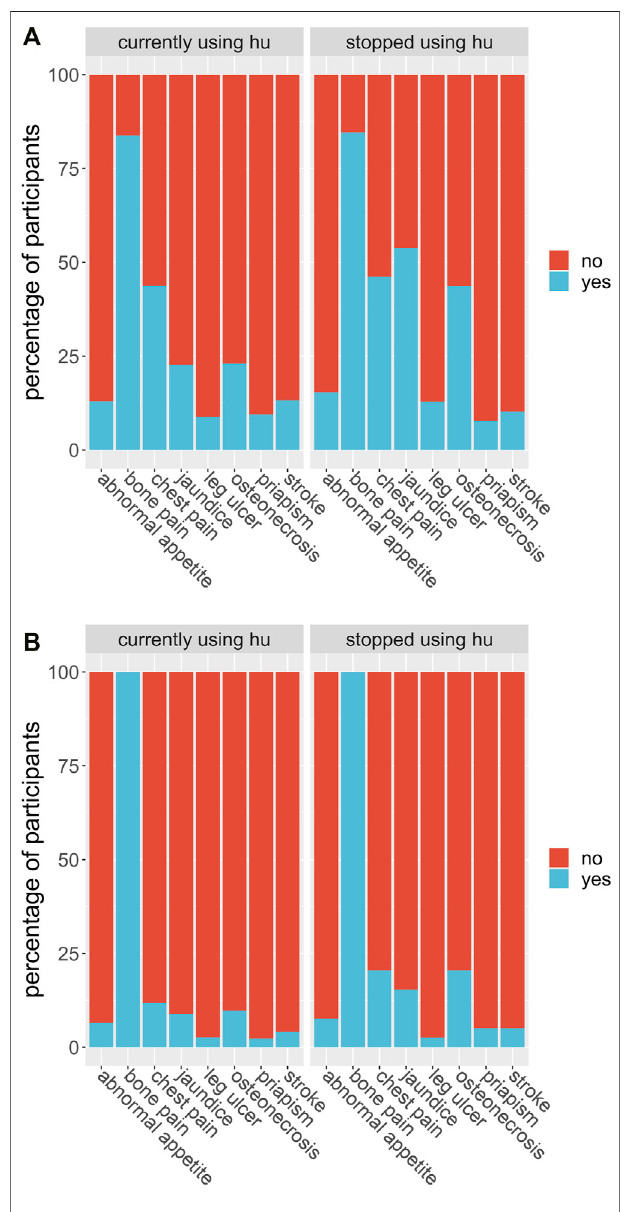
FIGURE6|(A) Participantswereaskediftheysufferedfromeachofalist of known sickle cell disease complications before they began their hydroxyurea treatment. The proportion of participants out of the entire study group who answered yes, they did suffer from that complication before treatment (blue) or no, they did not (red) are shown in the bar labelled by that complication (axis), for each complication in the list. (B) Participants were asked if they suffered from each of a list of known sickle cell disease complications after they began their hydroxyurea treatment.The proportion of participants out of the entire study group who answered yes, they did suffer from that complication during treatment (blue) or no, they did not (red) are shown in the bar labelled by that complication (axis), for each complication in the